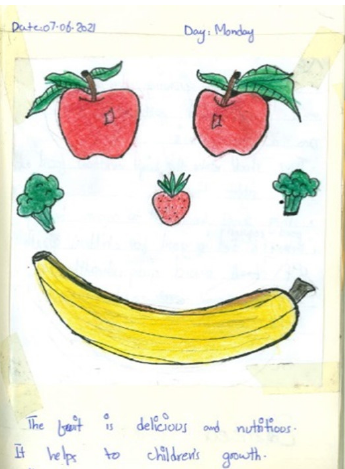
Figure 3. Jon’s photodiary: “the fruit is delicious and nutritious. It helps to children’s growth”. Food consistently underpinned the participants’ narratives and photodiaries which was reflected in how they made sense of malnutrition. However, there was some confu- sion when they were asked about the meaning of undernutrition ( ghizayat ki kami ), over- nutrition ( ghizayat ki ziyadti ), and vitamin and mineral deficiencies ( haya’teen or madi’niyat ki kami ). A few participants declared not knowing the answer, noted the great difficulty of the questions, or simply went silent. In the Urdu language, ghizayat ki kami can be literally translated as deficient in nutrients and ghizayat ki ziyadti as an excess of nutrients. Jannat’s description of overnutrition illustrates her sense-making: “overnutrition… when eat properly, it will be fine... not having in excess of things... disadvantage of some things. disadvantage…”. All these responses probably suggest unfamiliarity and/or unawareness with malnutrition words. Overnutrition was defined as an “excess of food” that appeared to impact people’s bodies and health. There was a general acknowledgement that overnutrition “has a harm- ful effect on the body” (Mary), and “our body will become fat” (David) if unhealthy items were consumed. The negative impact of eating food in excess was not only limited to these “bad” items; for instance, Sulman and Rimsha commented that eating banana or mango in excess might be detrimental to health. Some participants mentioned that overnutrition was not only related to unhealthy food and beverages but also to physical activity. Phys- ical inactivity was understood to be both the cause and the consequence of obesity. One participant (Sunny) recognised that losing weight was such a challenging and lengthy process. As opposed to overnutrition, many participants described undernutrition as a lack of (nutritious) food: “Not eating… not eating good food… eating fast food, oily food, street food, and not having vegetables, not eating fruits, not drinking milk, not drinking juice” (Rimsha). Undernutrition also appeared to have bodily connotations, which re- ferred to insufficient weight and height. Participants’ understandings of malnutrition went beyond physical references to suggest emotional implications. Participants noted that experiencing emotional distress was related to nutritional status: “this [undernutrition] is due to tension” (Mary). Jon com- mented that people do not take care of their diet when depressed, and Sakina said that some people do not eat at all and others eat loads when depressed or stressed. Interest- ingly, various participants viewed junk food as particularly harmful for health and well- being: “many people eat fast food. People who are overweight also eat it. They do not take care of their health (…) it [fast food] affects our brain and we have depression” (Rimsha). However, they did not acknowledge experiencing any psychological distress. In the fol- lowing quote, Qirat’s use of the words “the children”, “they”, and “we” indicates detach- ment from these experiences. This separation is apparent throughout their narratives and will be analysed in more detail in Theme 3.